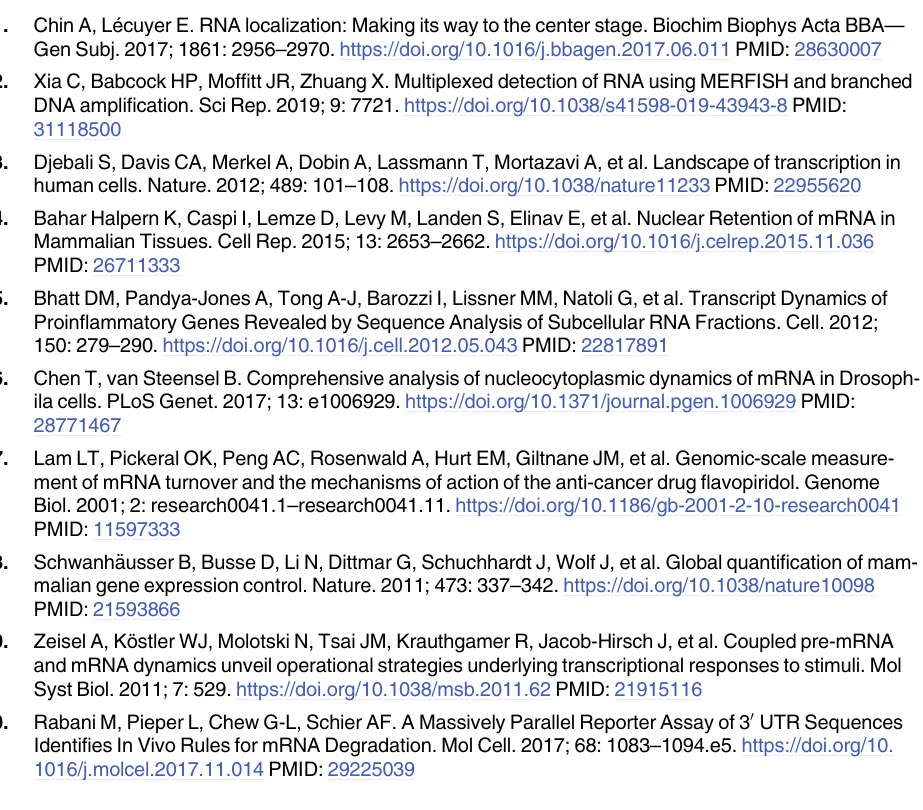
S4 Table. GO Terms analysis of polyadenylated nuclear and cytoplasmic polyadenylated RNA. S5 Table. Estimated kinetic parameters and selected models at step 1 and step